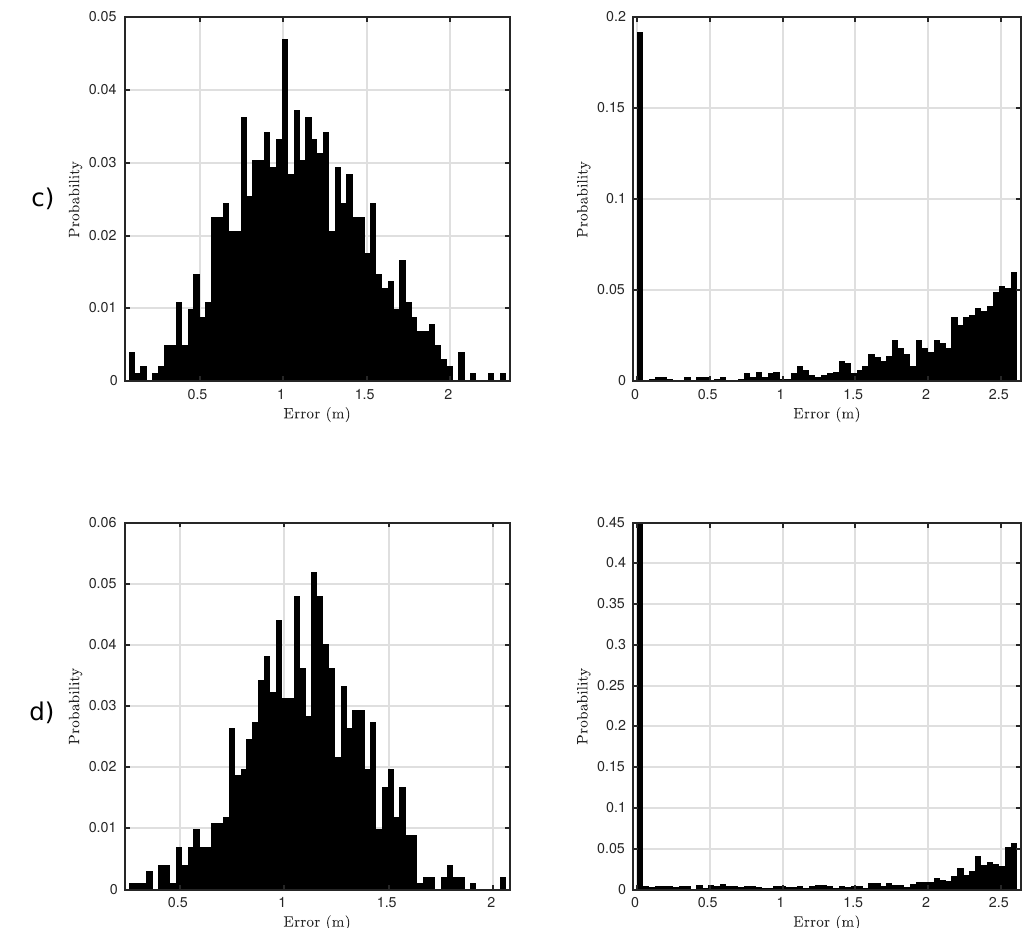
Figure 11. Histograms associated to the averaging strategy ( left column ); and to the proposed mode-based error mitigation ( right column ). ( a ) one-shot measurement samples filtering, ( b ) two-shot measurements samples filtering, ( c ) five-shot measurements samples filtering and ( d ) ten-shot measurements samples filtering.